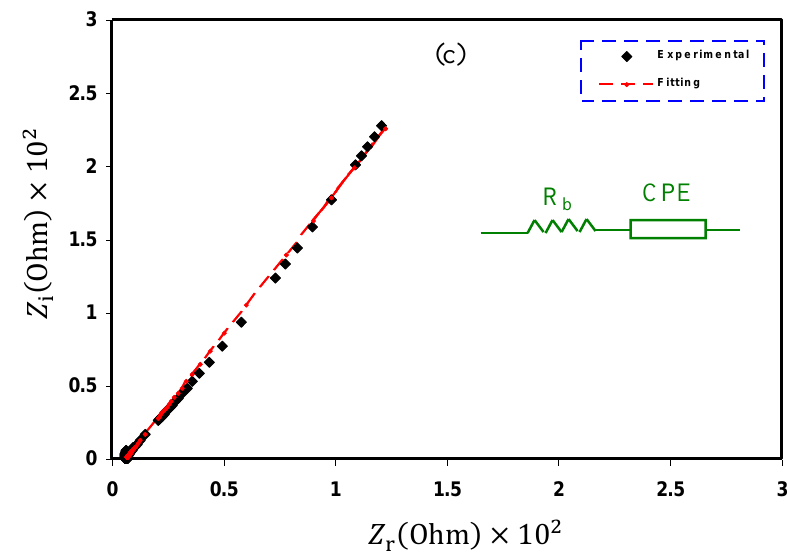
Figure 2. EIS plots for ( a ) PMNG-1, ( b ) PMNG-2, and ( c ) PMNG-3 electrolyte films.